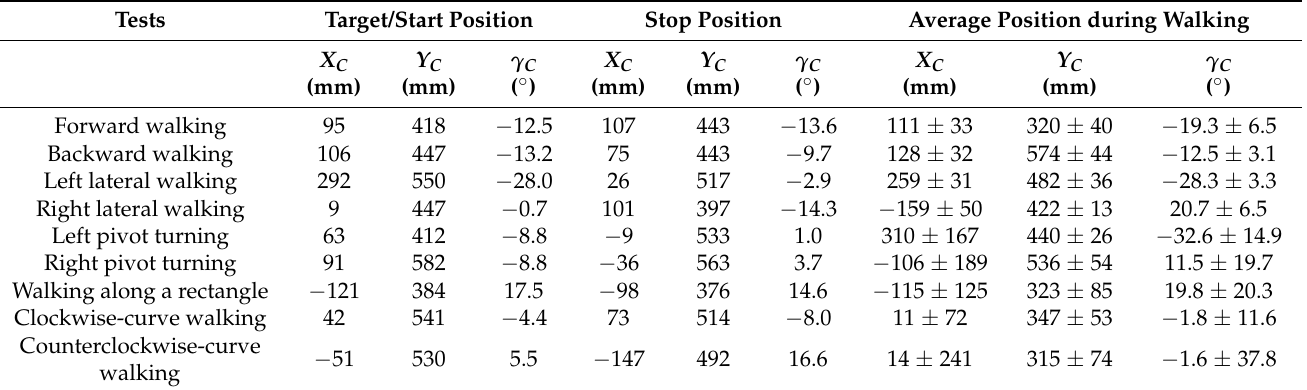
Table 2. Result of Walking Tasks in LCS U